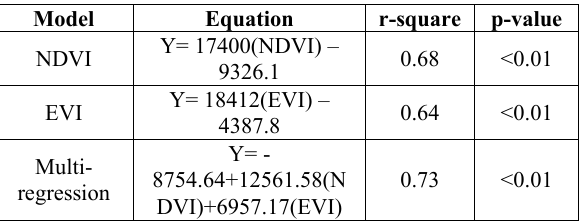
Table 2. Satellite databased paddy yield model